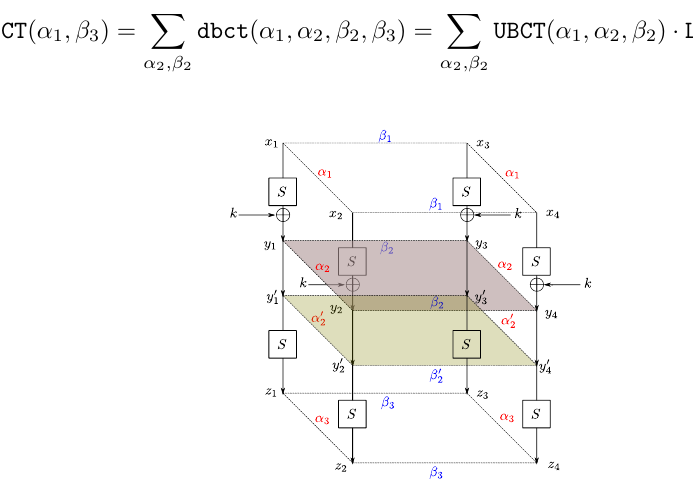
Figure 4: General DBCT with a complex linear layer in